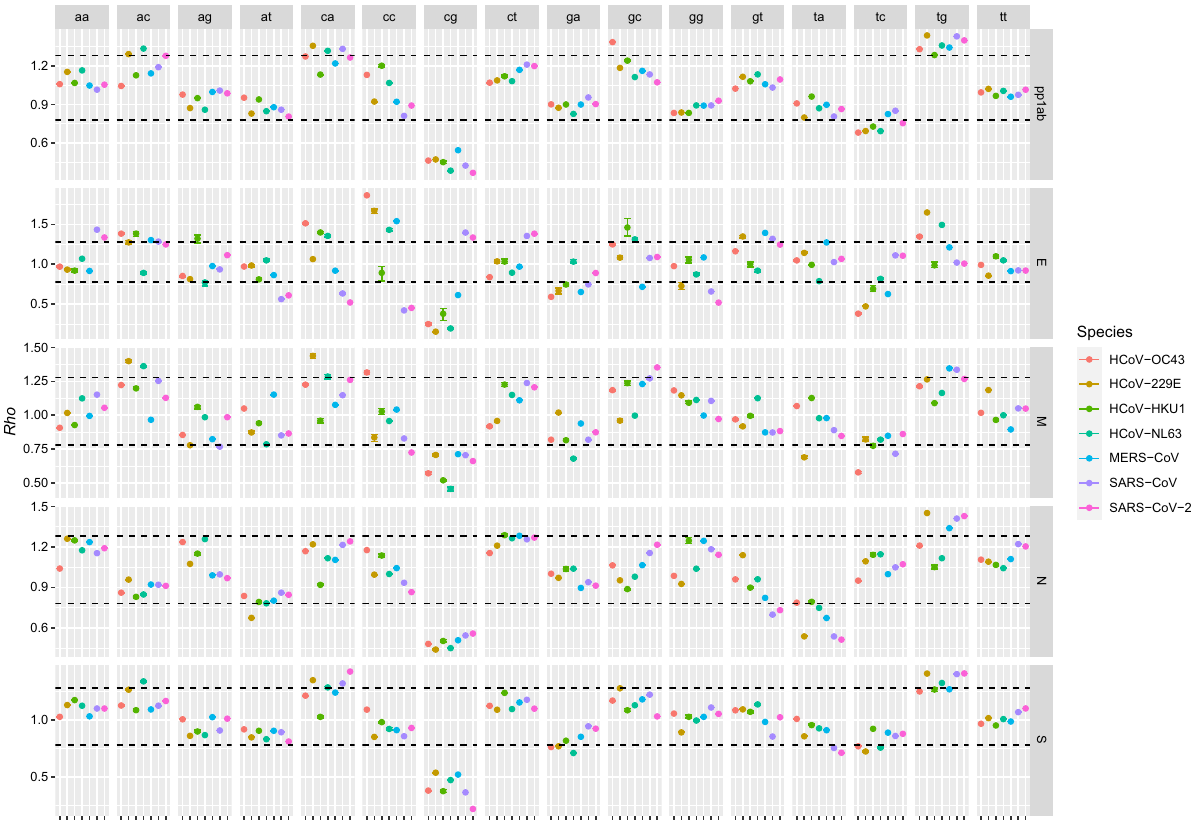
Figure 1. Mean (point) and 95% confidence intervals (errorbar) of Rho statistic calculated for each dinucleotide pair. Different gene-species pair are reported in different cells. Dashed lines represent the cut-offs defined by Karling et al.